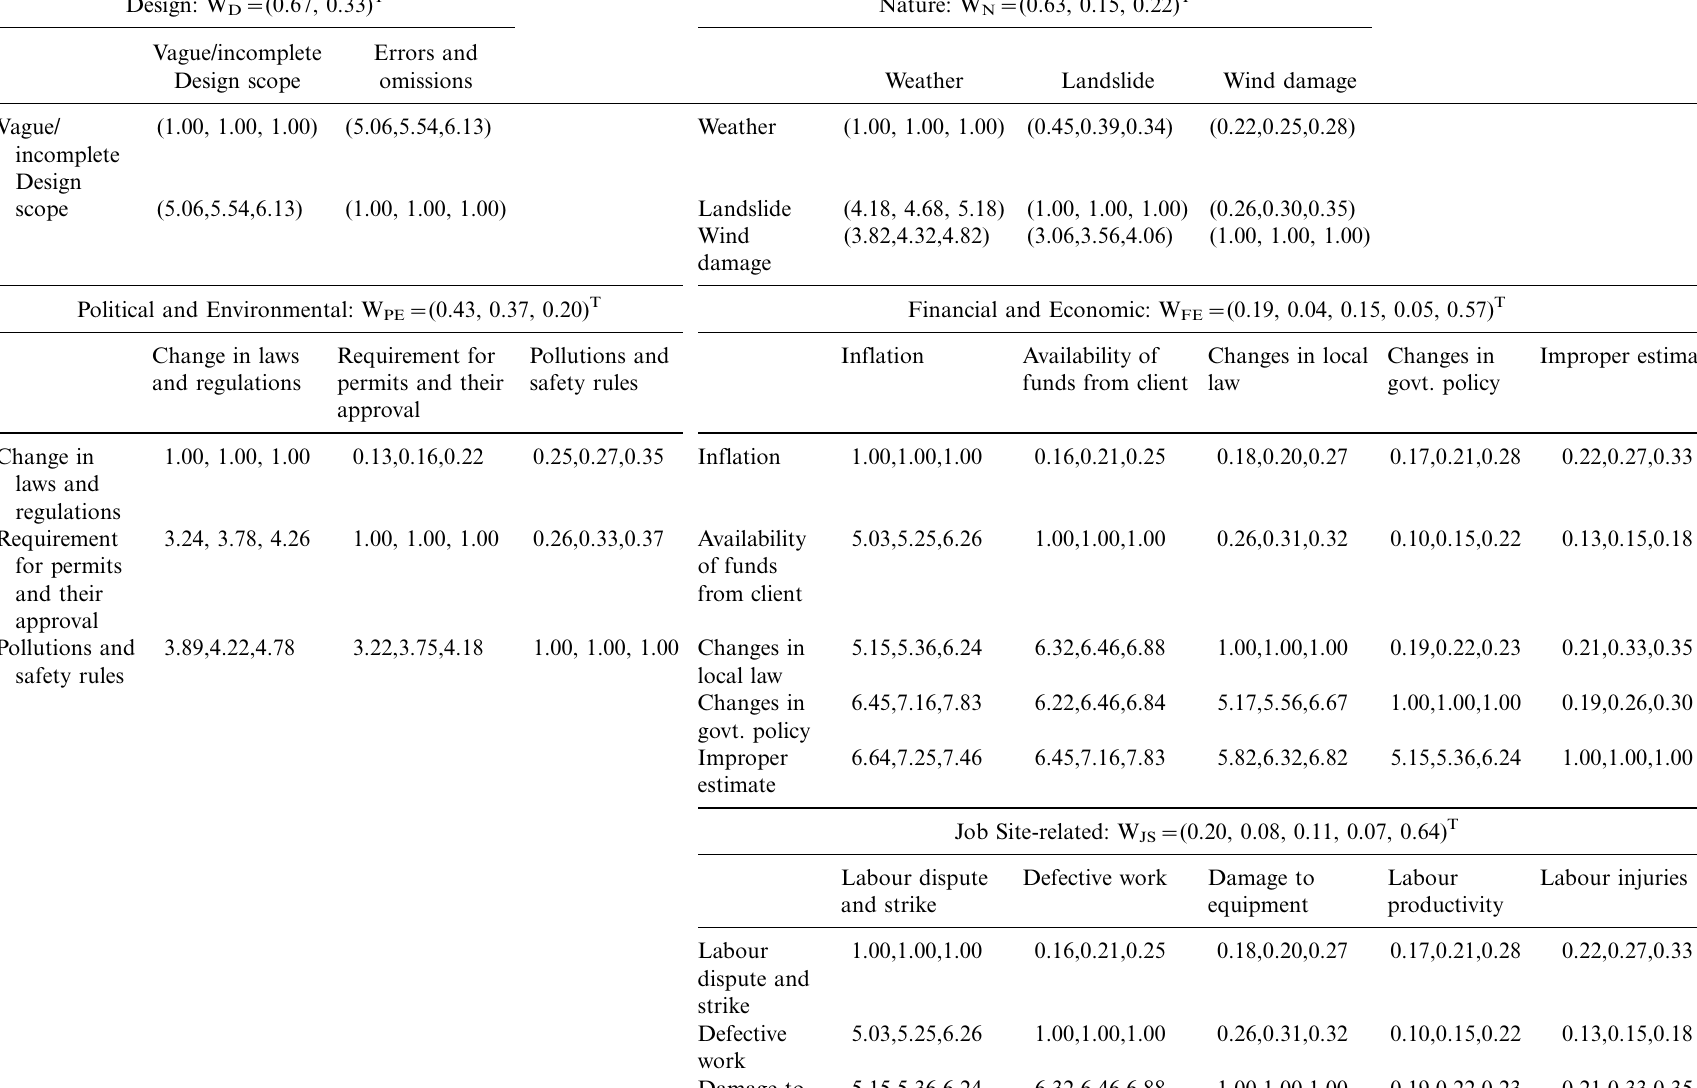
Table 8. (Level 3) Matrices of pairwise comparisons and respective normalized weigh vectors Design: W D (cid:2) (0.67, 0.33)